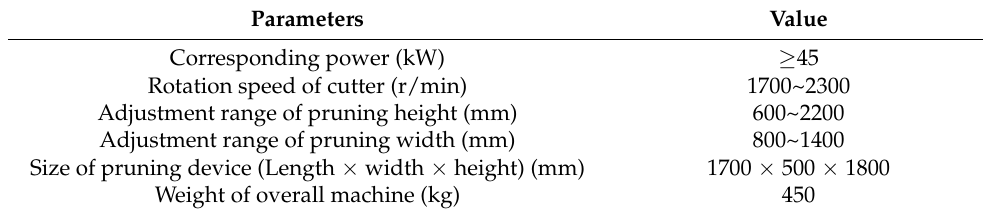
Table 2. Main technical parameters of shaping and pruning machine for jujube